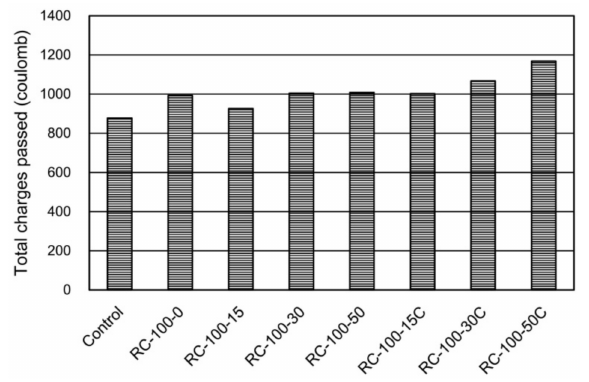
Figure 5. Chloride ion penetration at 56 days